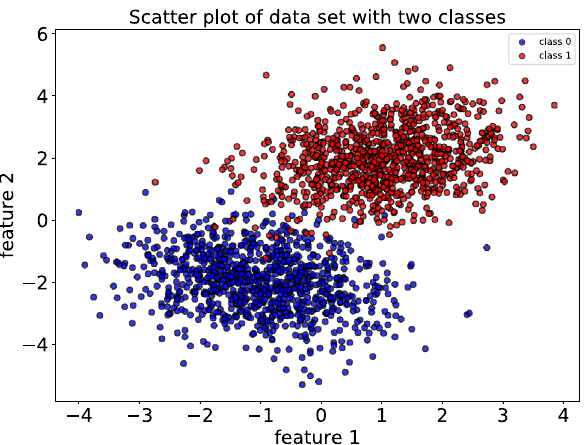
Figure 5. The scatter plot of data set with two classes. The data points are generated with two Guassian distributions possess different mean values and covariance